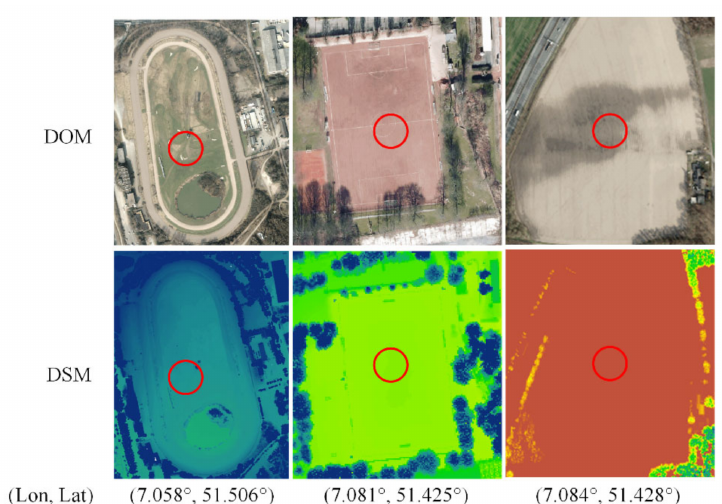
Figure 10. Selected laser points in areas with flat